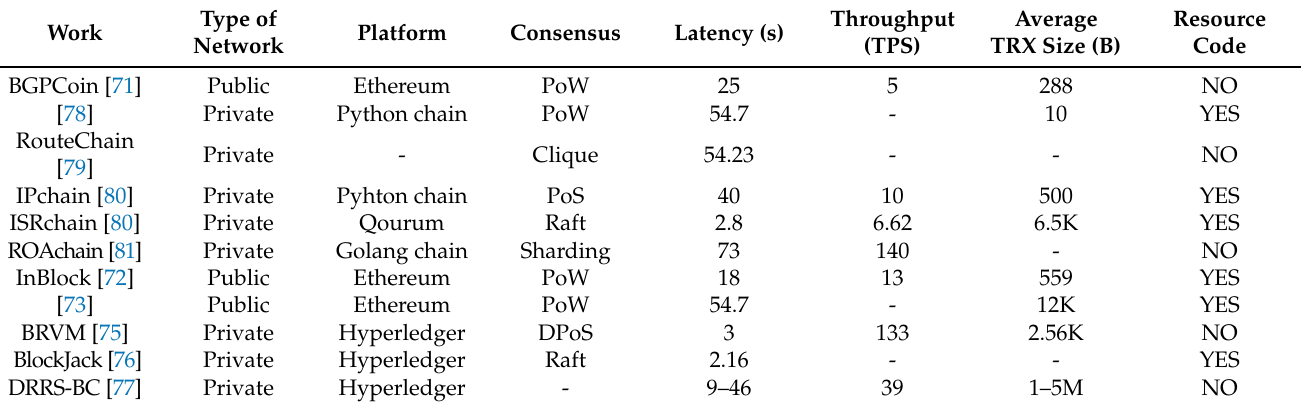
Table 5. Comparison of blockchain implementations in analysed